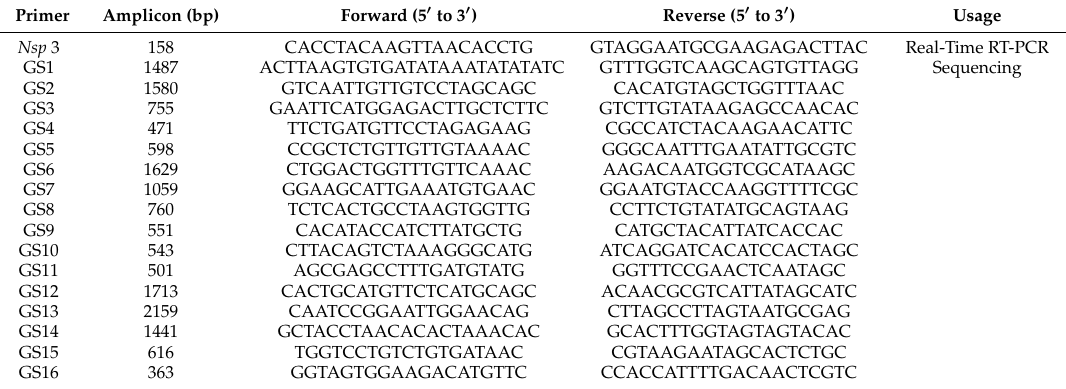
Table 1. Primer sets used for real-time RT-PCR and full genome